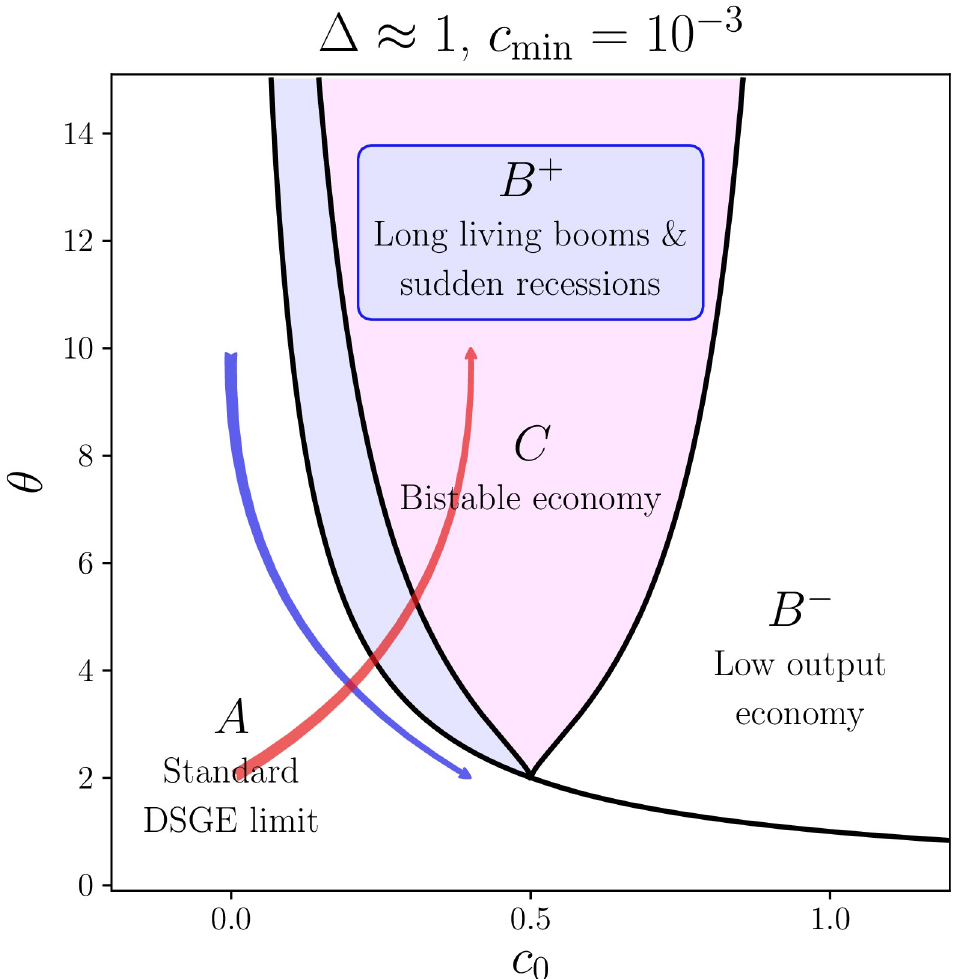
Fig 1. In the figure we show a sketch of the phase diagram as in the homogeneous case, with highlighted the different phases and their properties. In red and blue we draw two possibilities for the choice of the θ ( c 0 ). The arrows point in the same direction as the increase in wages’ levels. This figure is meant to be a guide to help the reader to understand the model and the choice of parameters.